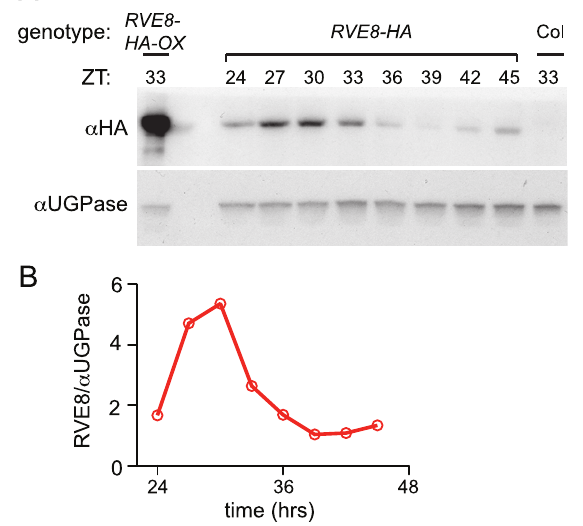
Figure 4. RVE8 protein accumulates in the subjective after- noon. Col, RVE8::RVE8-HA and 35S::RVE8-HA seedlings were entrained in 12 hr light:12 hr dark for 6 days before being released to constant white light (55 mol m 2 2 s 2 1 ) (A) Plants were harvested at the indicated times and extracts were subjected to immunoblot analysis using either an anti-HA antibody (upper panel) or an anti-UGPase antibody (lower panel). (B) Data shown in panel (A) was quantified using ImageQuant software. Data are representative of two independent experiments.